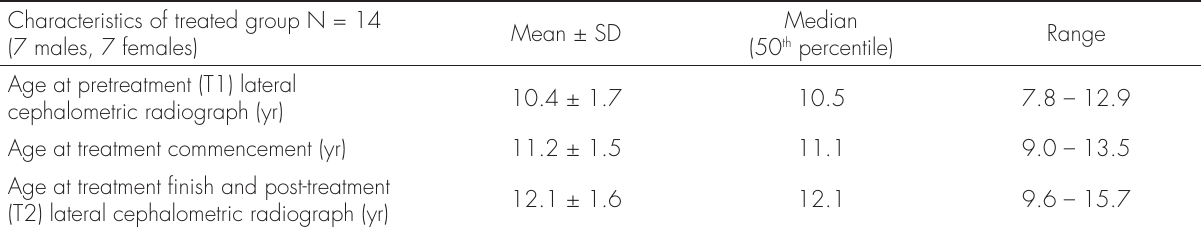
Table I. Descriptive statistics for the treated group at pretreatment (T1) and post-treatment (T2).